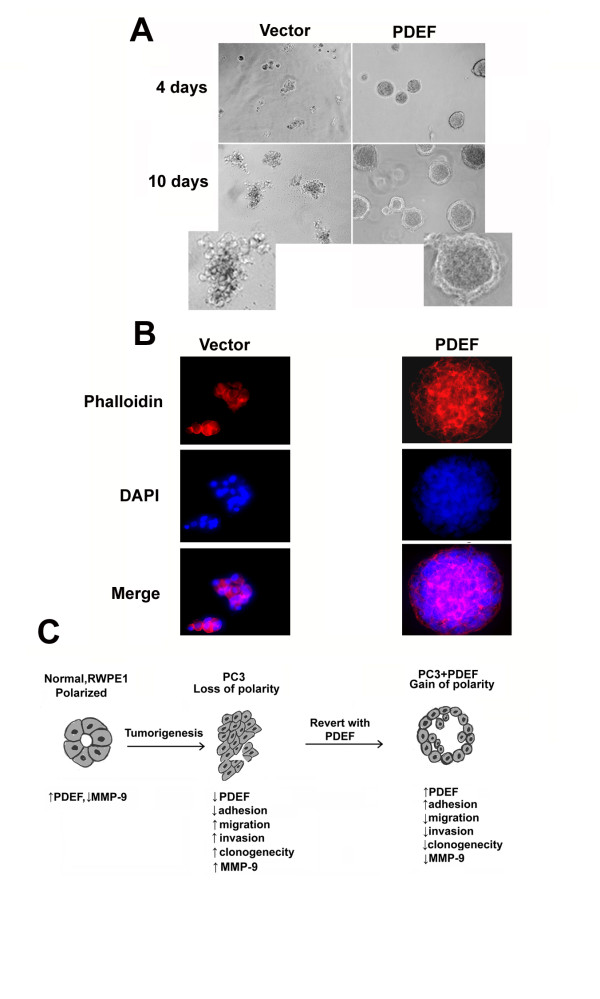
Effect of PDEF expression on cells grown in three dimensional cultures. A, representative images of three dimensional matrigel culture of PC3 cells with and without PDEF showing phenotypic reversal. Representative phase image obtained at various days in culture using 20X objective. B, Fluorescence microscopic images of PDEF PC3 cells and vector control cells after phalloidin and DAPI staining in 3 D cultures. C) Schematic depiction of the effects of PDEF expression in Prostate cancer cells.